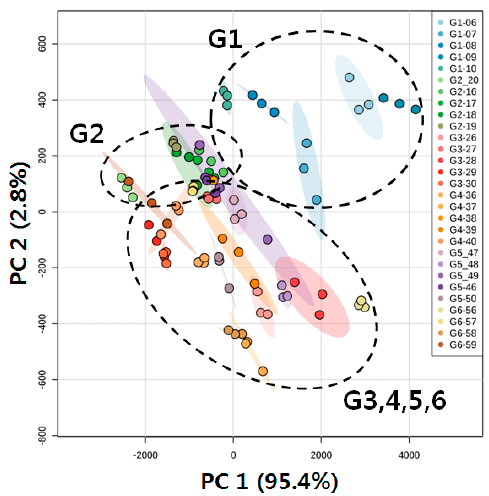
Figure 4. PCA score plot of lipid profiles obtained from thirty individual samples of normal controls (G1) (n = 5), SHR (G2) (n = 5), SHR + Drug 100 mg / kg (G3) (n = 5), SHR + ASF 200 mg / kg (G4) (n = 5), SHR + ASF 400 mg / kg (G5) (n = 5), and SHR + ASF 600 mg / kg (G6) (n = 5).